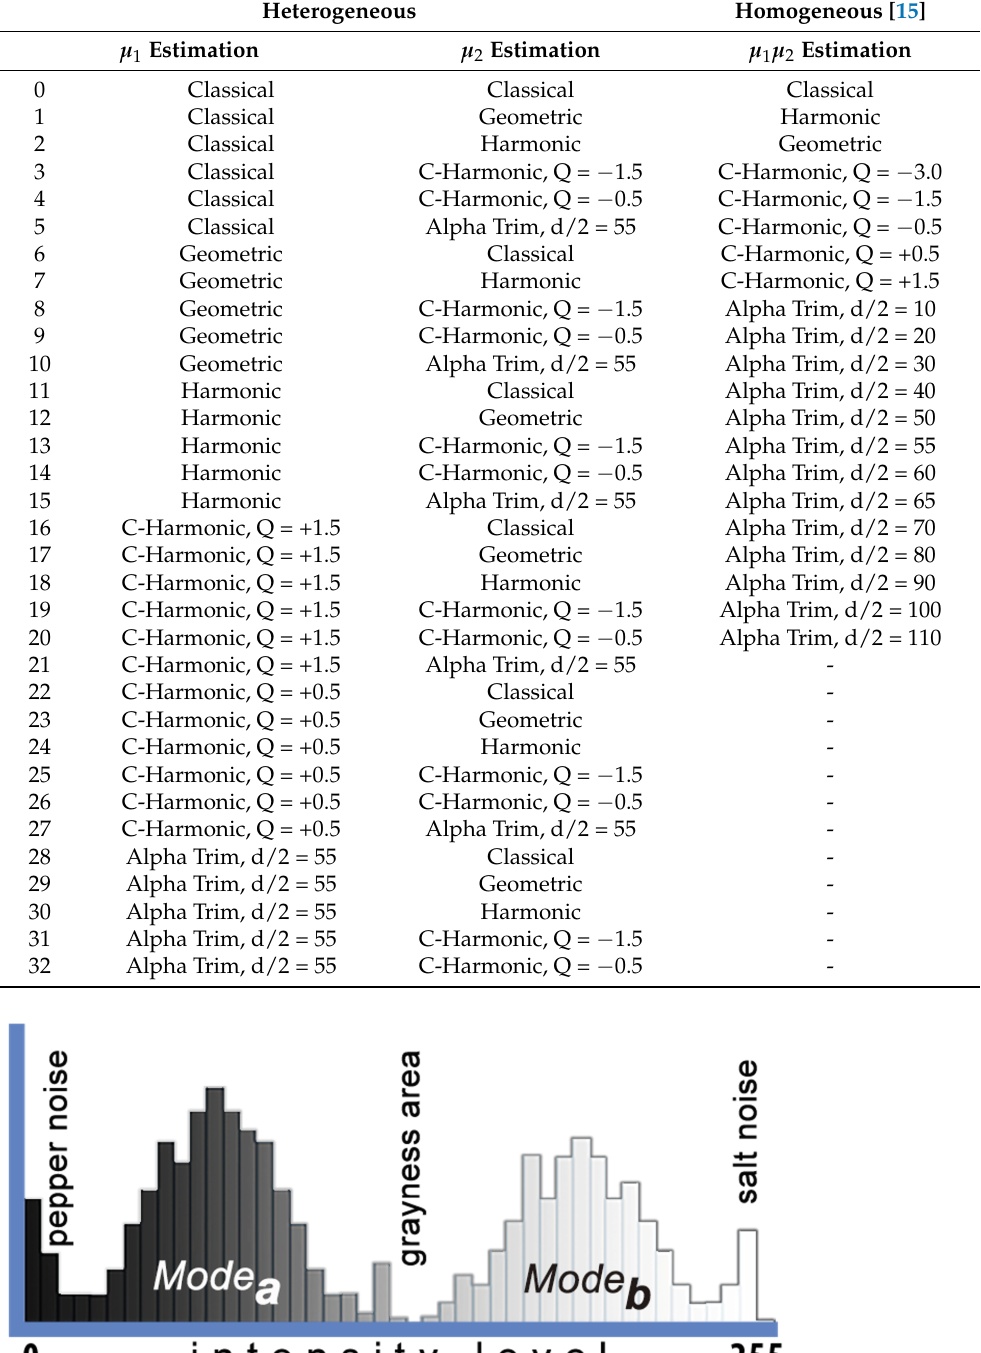
Table 2. µ 1 and µ 2 estimation inputs of heterogeneous and homogeneous mean filter approaches for MCET.